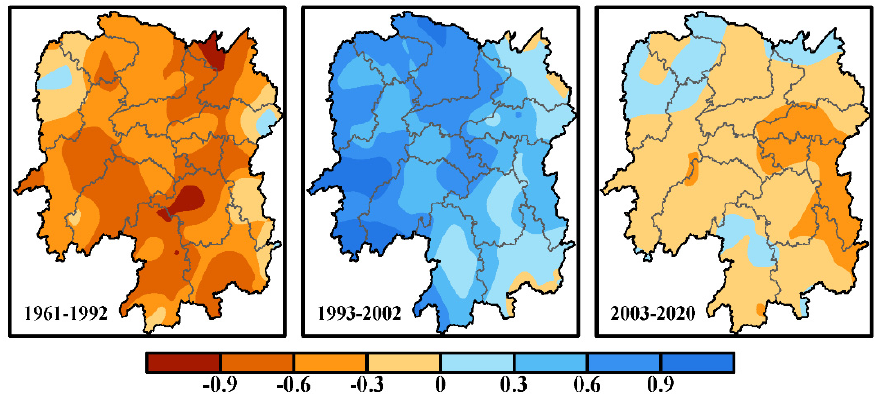
Figure 4. Spatial distributions of the SPI values in different decades over the Dongting Lake basin.